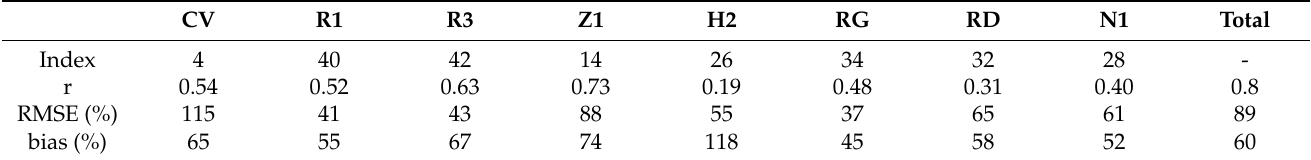
Table 3. Comparison between added CRU rainfall + irrigation and TSEB/MODIS monthly evapo- transpiration estimates at the irrigated perimeters for 2011 agricultural